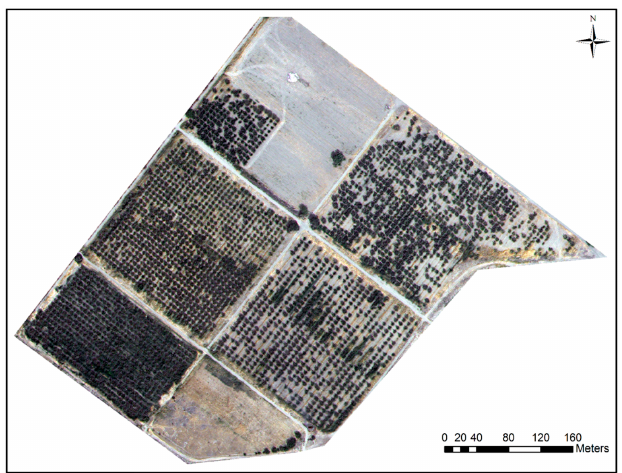
Figure 1. R, G, B true color composite for the study area (satellite image courtesy of the DigitalGlobe Foundation).